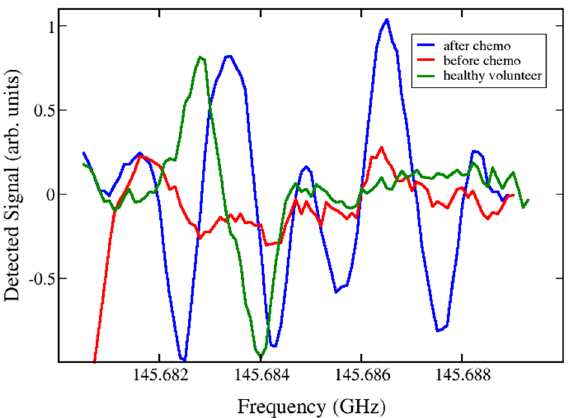
Figure 2. Experimental detection the absorption spectral lines of methyl butyronitrile (C 2 H 5 CHCNCH 3 ) near the frequency f c1 = 145.6832 GHz and glycine conformer II (H 2 NCH 2 COOH) near the frequency f c2 = 145.6864 GHz detected in the sample of patient 2 before (red) and after chemotherapy (blue), together with the corresponding reference measurement for healthy volunteer 1 (green). There are two close lines differing by less than tens of Hz for methyl butyronitrile, given in the databases 31,32 at the frequency fc = 145.6833846 GHz, characterized by Lg I = − 4.9041 and quantum numbers (v = 0) 64 54 10 ← 64 53 11 and (v = 0) 64 54 11 ← 64